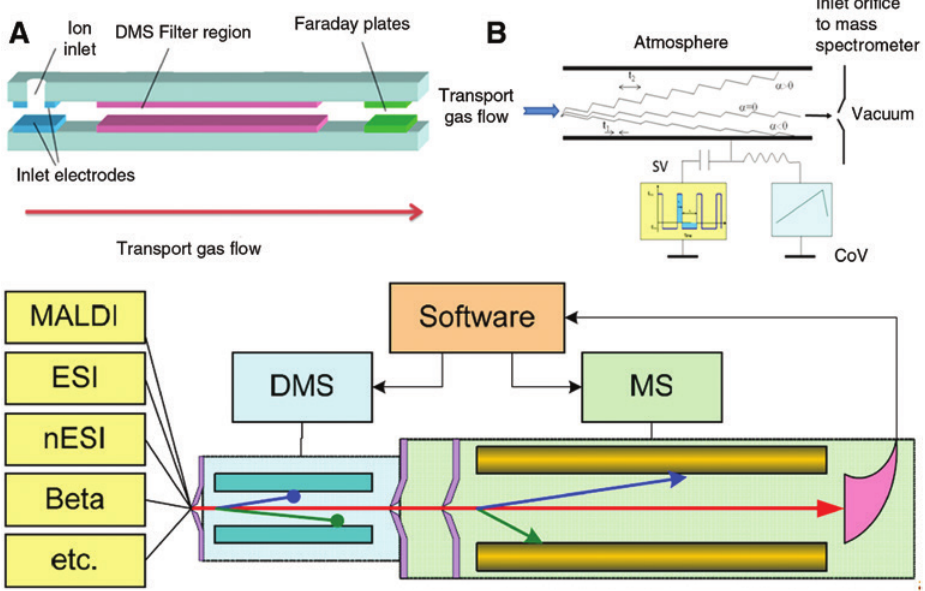
Figure 3: Schematic of DMS-MS principles and interface operation.